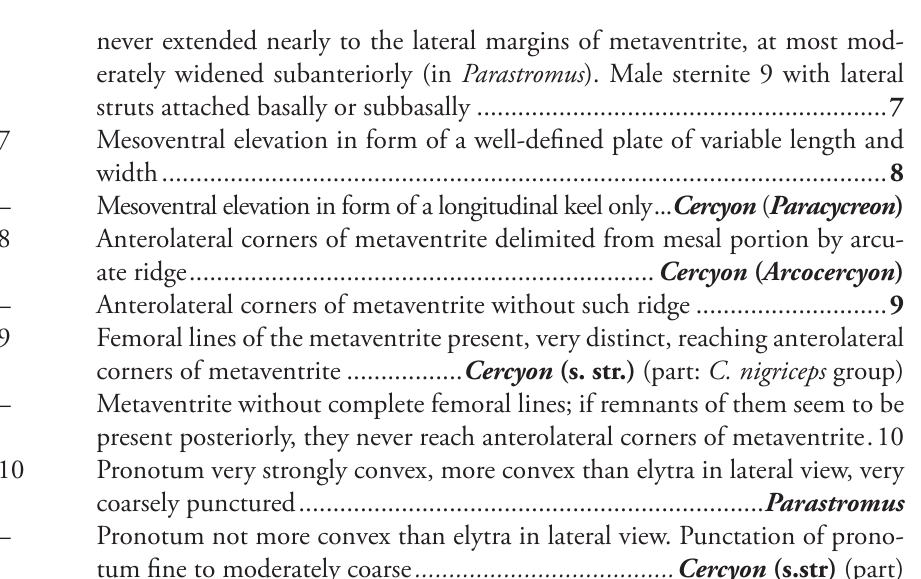
Cercyon ( Acycreon ) Orchymont, 1942 Acycreon Orchymont, 1942: 3.